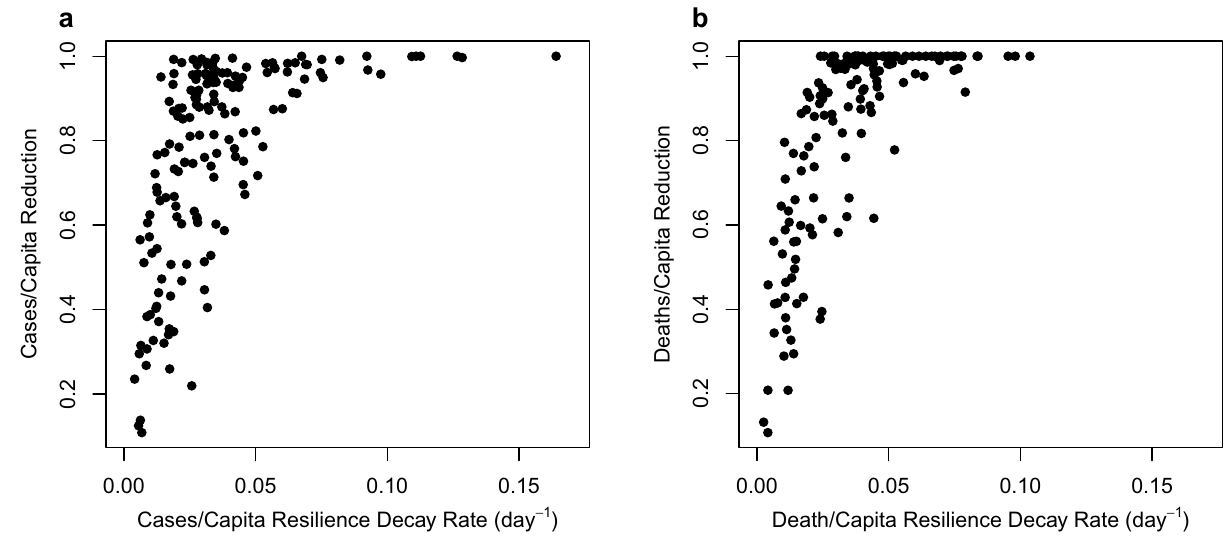
Figure 2. Comparing resilience to, and reduction of, COVID-19 across countries. ( a ) cases/capita (n = 165, ρ =0.70, p < 0.0001), ( b ) deaths/capita (n = 150, ρ =0.78, p <